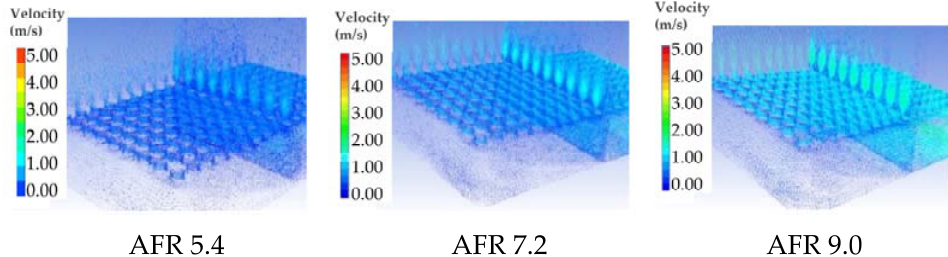
Figure 9. Speed of combustion gas at perforated plate.